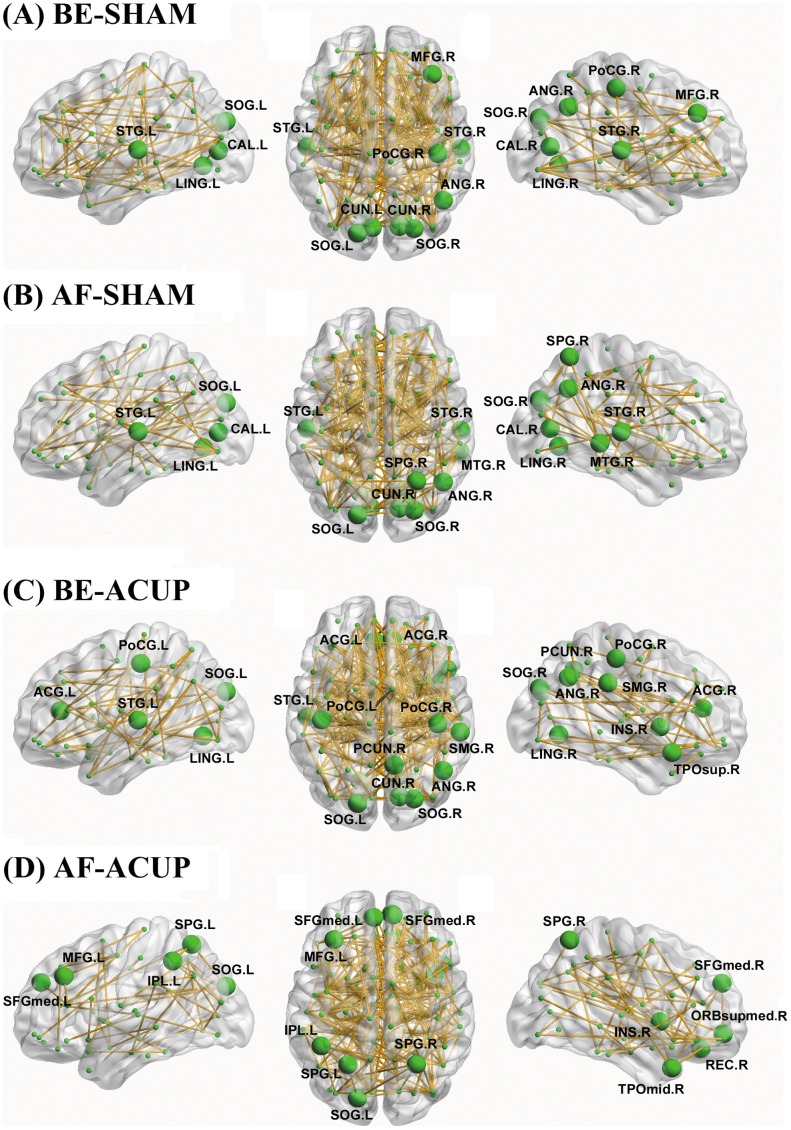
The hubs of functional brain networks.The nodal sizes indicate their relative nodal degree within each condition. Regions with normalized nodal degree greater than mean + SD were identified as hubs. Note that the connectivity backbone (sparsity  = 5%) was obtained by thresholding the mean correlation matrix under each condition. For more details, see Table 2. L, left; R, right.